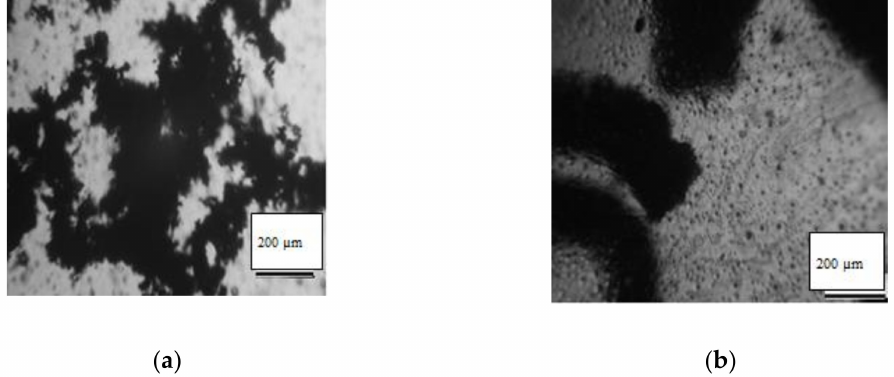
Figure 5. Optical micrographs of E / 0.5MWCNT ( a ) and E / 0.5EG ( b ) samples (the unit scale is 200 µ